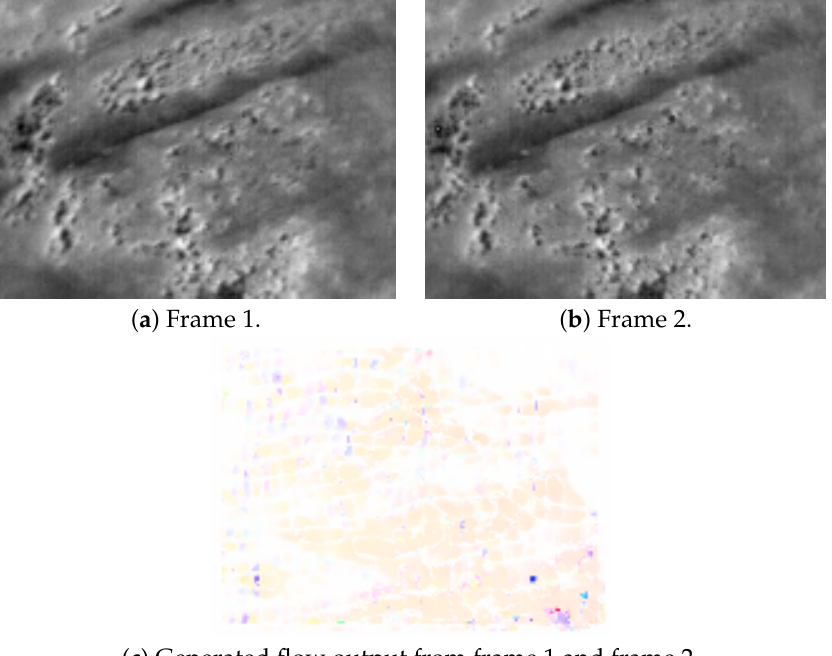
Figure 9. A sample sequence of thermal data and its generated ground truth from dense the optical flow Farneback algorithm in